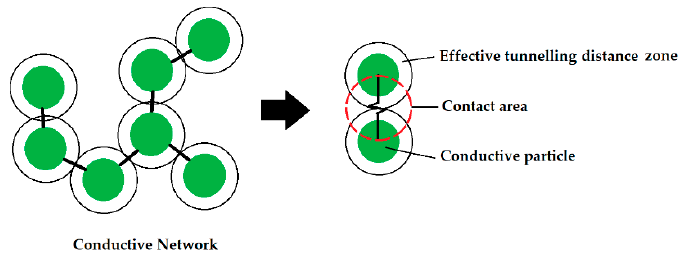
Figure 10. The tunneling effect between conductive particles dispersed in an electrically non- conductive composite.